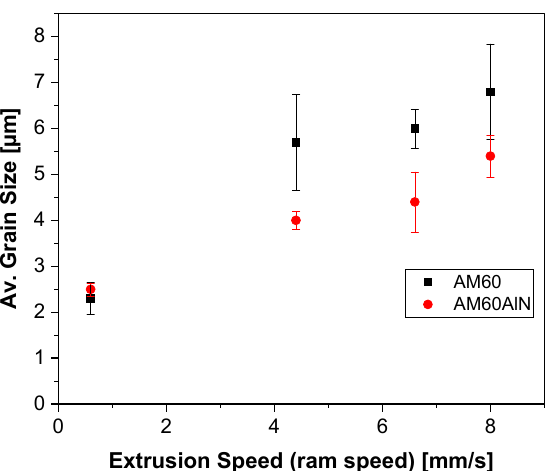
Figure 3. Average grain size values of extruded AM60 and AM60 + 1 wt.% AlN series.